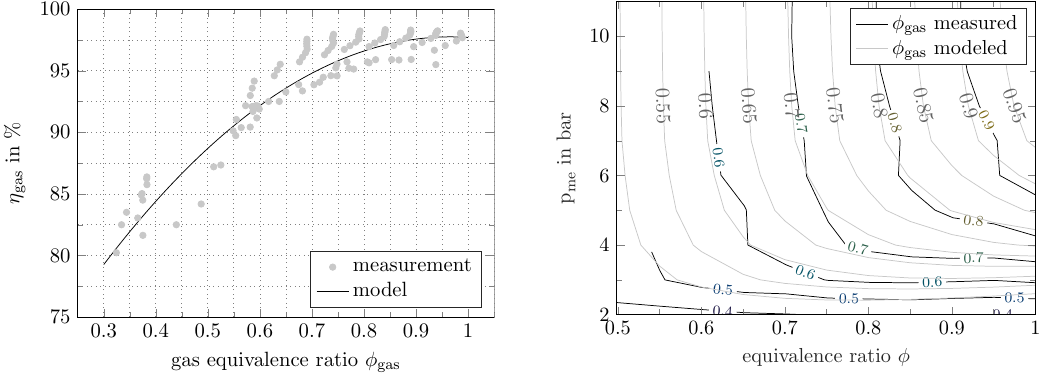
Figure 8. ( Left ) The relation of the gas conversion efficiency η gas to the gas equivalence ratio φ gas can be well approximated by a second order polynomial function; ( Right ) For a mean effective pressure p me below approximately 4 bar the gas equivalence ratio φ gas is not dependent on the equivalence ratio φ